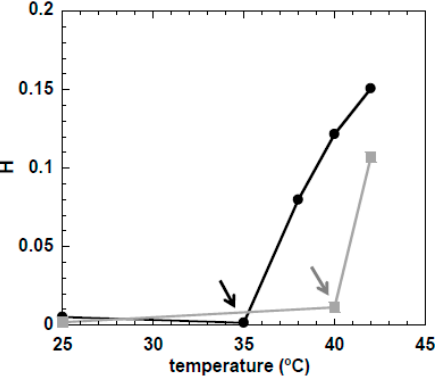
Figure 5. Variation of the H parameter with temperature for the 5 wt % (grey squares) and 10 wt % (black circles) MCC samples dissolved in NaOH(aq.). The arrows indicate the Tg .